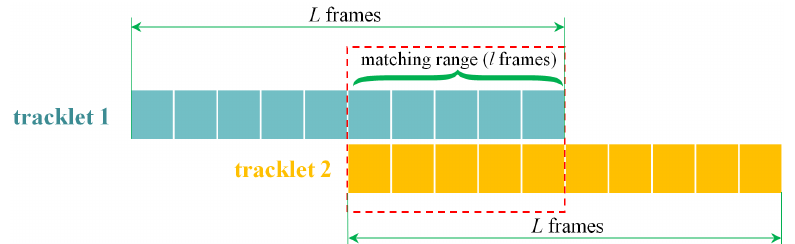
Figure 8. Connect two tracking segments according to players’ positions within the matching range of l frames. For example, suppose the batch size is set as L : both tracklet 1 and tracklet 2 contain L frames with l frames being overlapped. We call the overlapped l frames matching range frames. Then we calculate the distance between the two positions frame by frame within the matching range. If the distance is less than a given threshold, we call it a match. If not, a mismatch. Only if the matching number of times overpasses 80%, we then connect the two tracklets. Otherwise, we consider the current tracklet segment a new